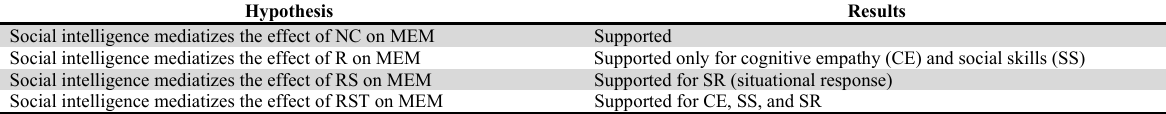
Hypothesis test Hypothesis